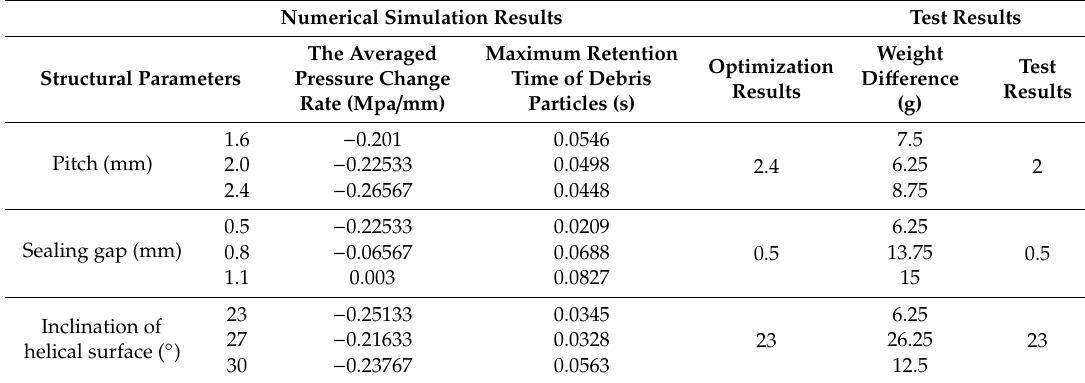
Table 1. Optimization results of structural